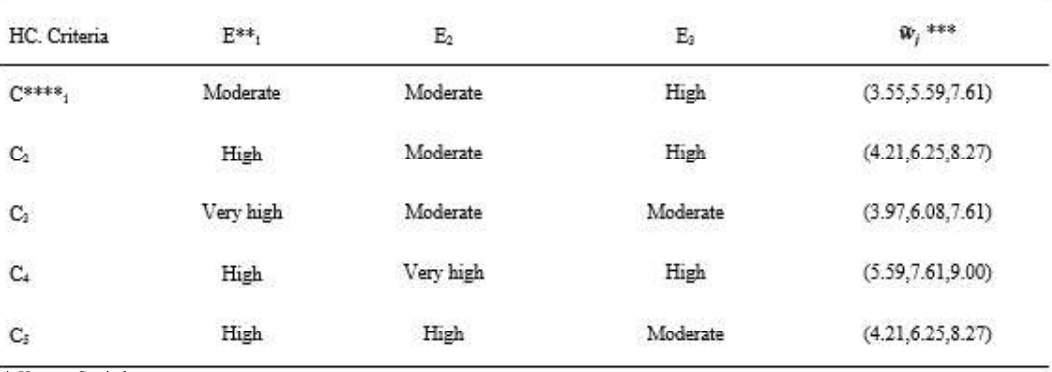
Table 3: The fuzzy weighting of HC* indicators